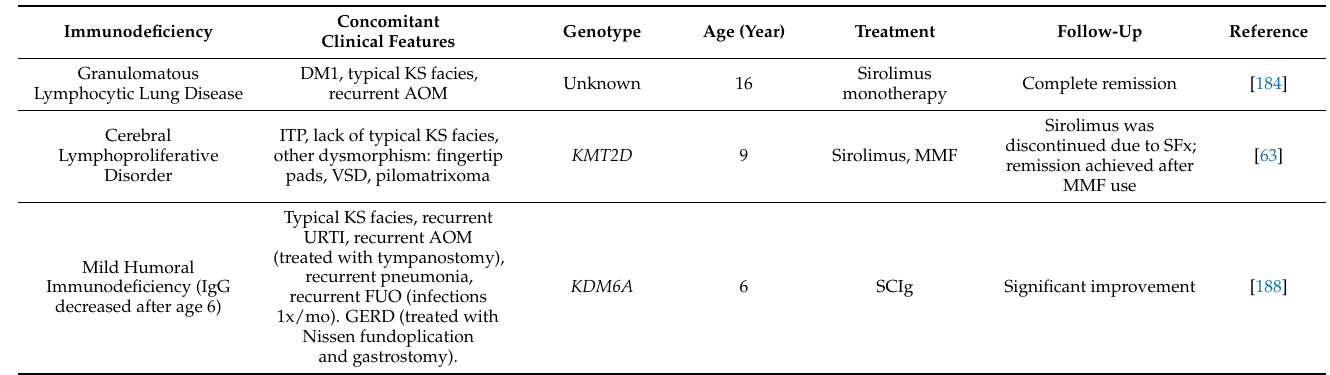
Table 6. Rare autoimmune manifestations reported in the literature. AOM—Acute Otitis Media; DM1—Diabetes Mellitus Type 1; FUO—Fever of Unknown Origin; GERD—Gastroesophageal Reflux Disease; ITP—Immune Thrombocytopenic Pur- pura; MMF—Mycophenolate Mofetil; SCIg—Subcutaneous Immunoglobulins; SFx—Side Effects; URTI—Upper Respiratory Tract Infection; VSD—Ventricular Septal